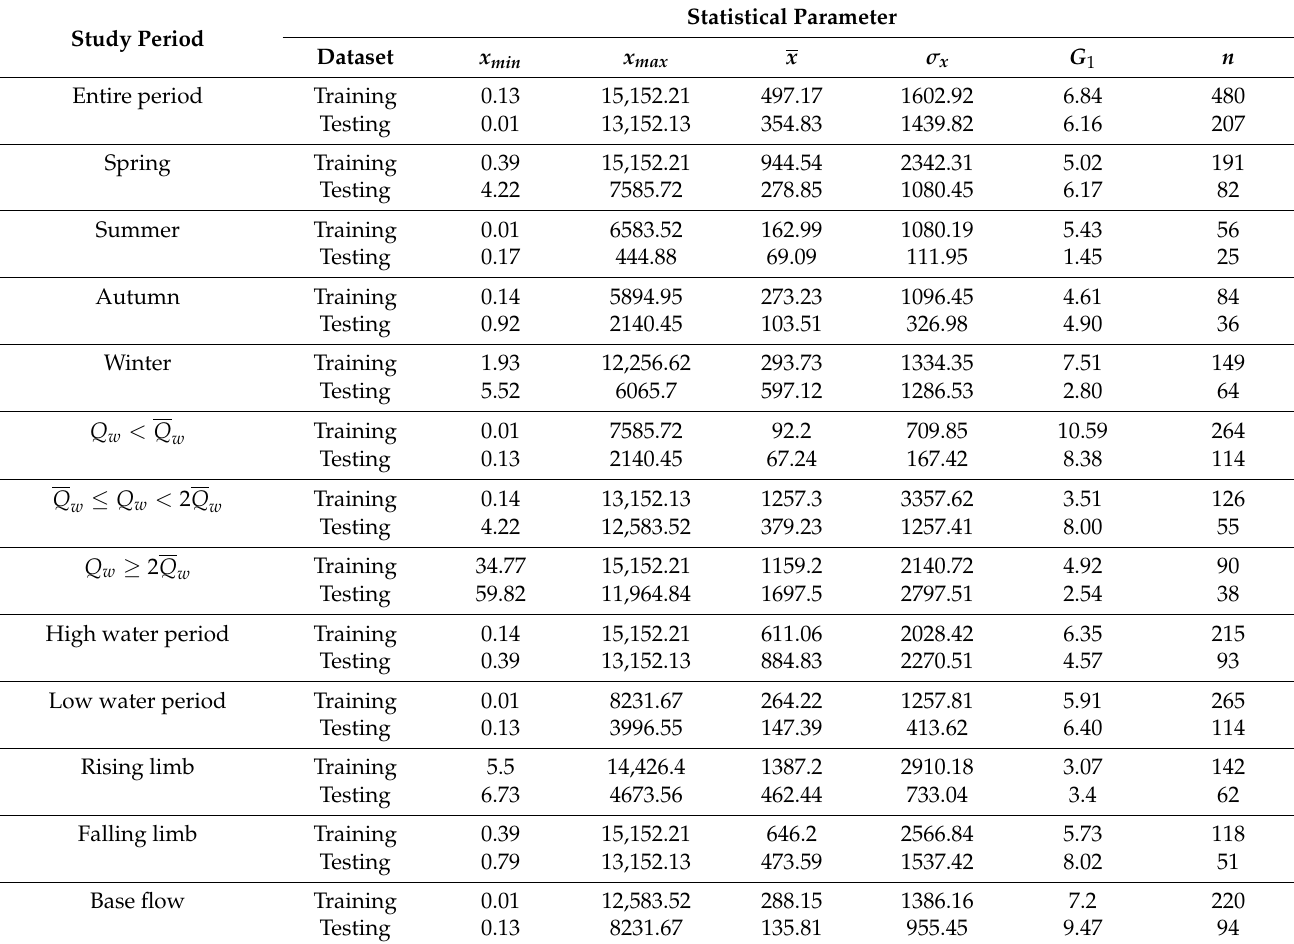
Table 3. Statistical values of SSC for the training and testing datasets 3